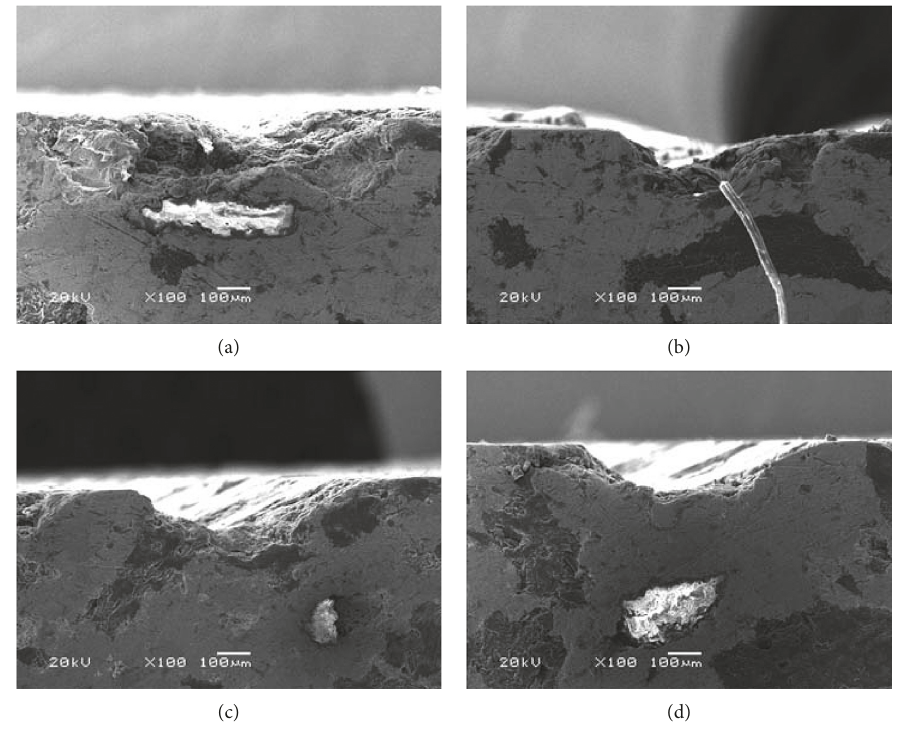
Figure 9: Fracture morphology of grooves. (a) a p (cid:31) 50 μ m. (b) a p (cid:31) 70 μ m. (c) a p (cid:31) 90 μ m. (d) a p (cid:31) 110 μ m.